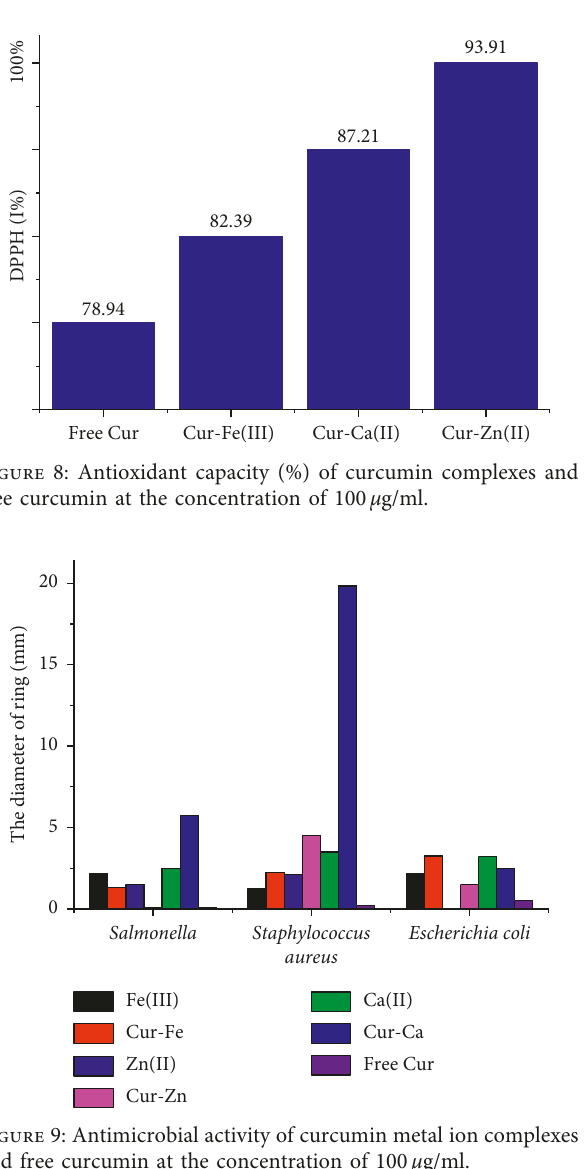
Figure 7: Transmission electron microscopy (TEM) analysis of curcumin complexes. (a) Cur-Ca(II); (b) Cur-Zn(II); (c) Cur-Fe(III).